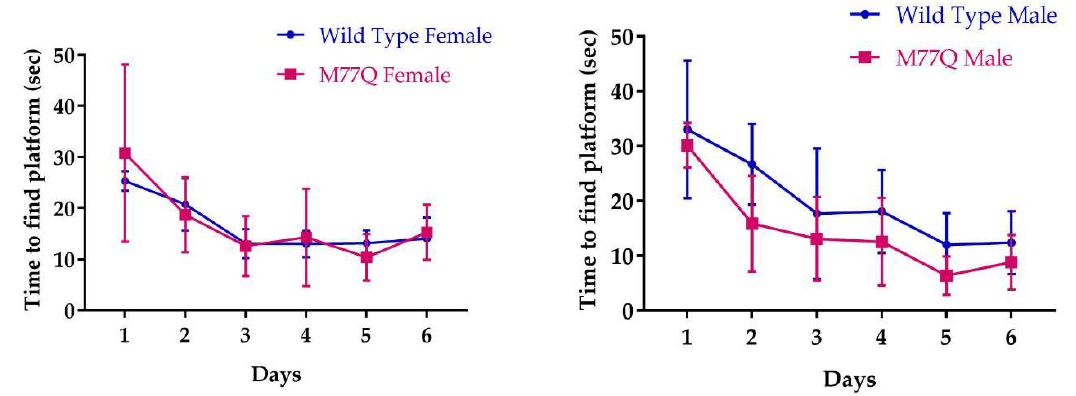
Figure 12. Learning performance on the Morris water maze. We tested 7 wild type and 5 M77Q males and 7 wild type and 7 M77Q females.